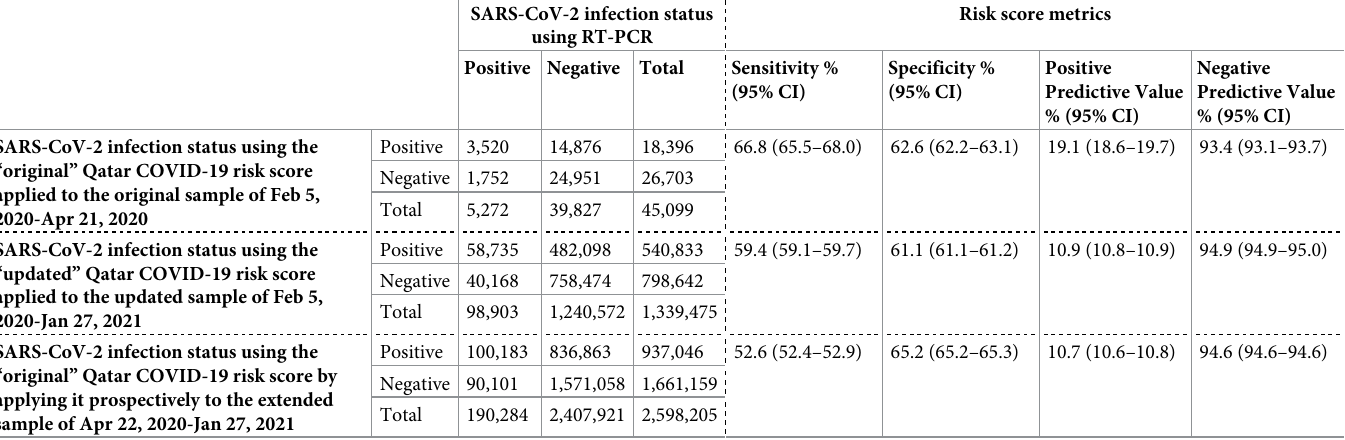
Table 3. Validation and diagnostic performance of the Qatar COVID-19 risk score, assessed using measures of sensitivity, specificity, positive predictive value, and negative predictive